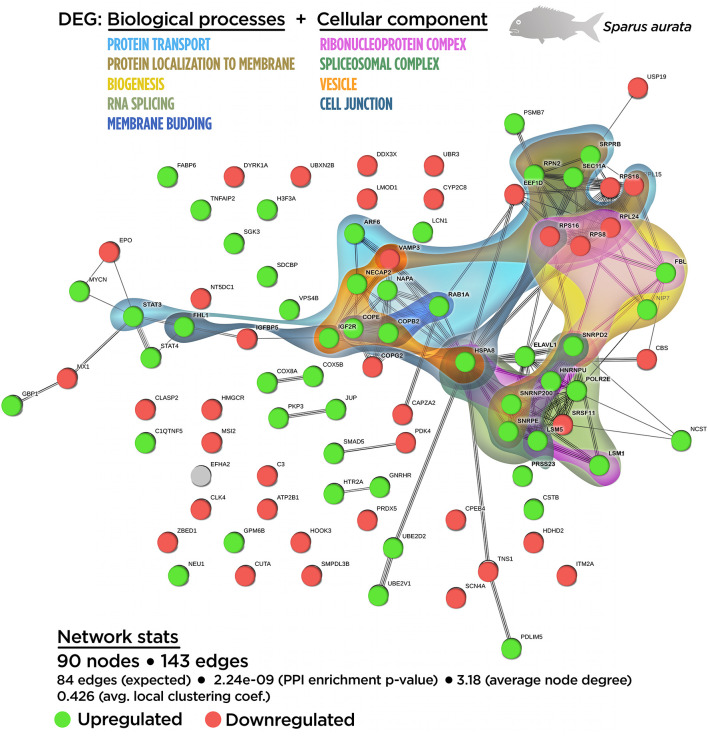
Integrative ameboid graphic for the biological processes and cellular components obtained from the skin transcripteractome analysis in gilthead sea bream fed with SDPP supplemented diet. Each node represents one differential expressed gene (DEG) obtained from the skin transcriptomic analysis. The DEG modulatory profile is represented with green (upregulated) and red (downregulated) into each node. The integrative cluster analysis groups the DEGs classified into the GO biological process or cellular component enrichment analysis. The set of these GO enrichment pathways are represented with different colors (bottom). The functional network statistics (Network stats) details are indicated (bottom).